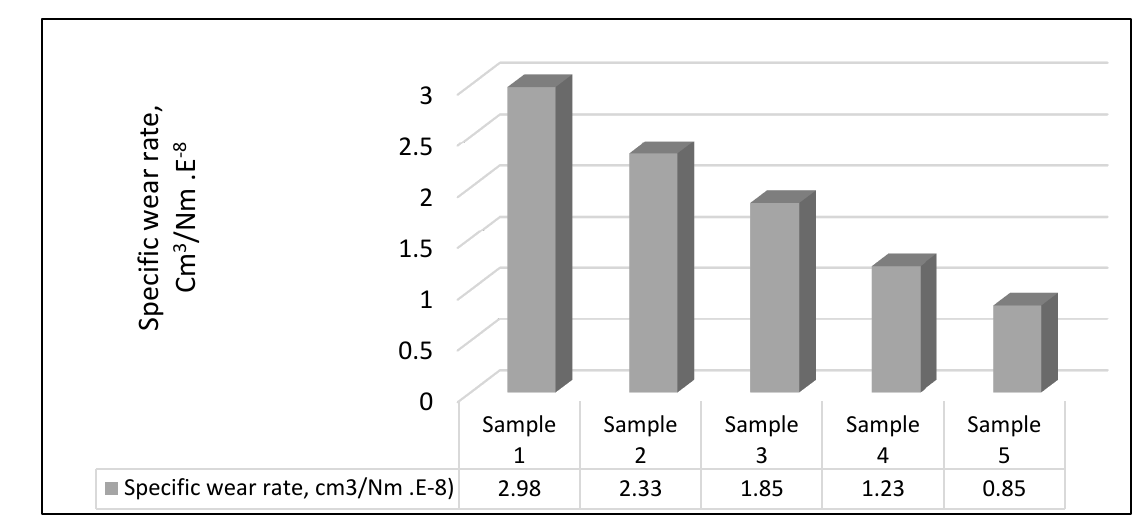
Figure 8. Wear rates for all sintered samples.